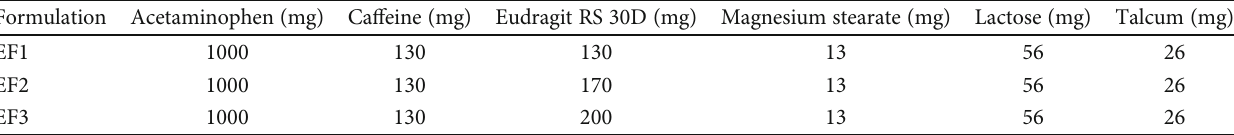
Table 1: Formula for the formulation of acetaminophen and ca ff eine using Eudragit RS